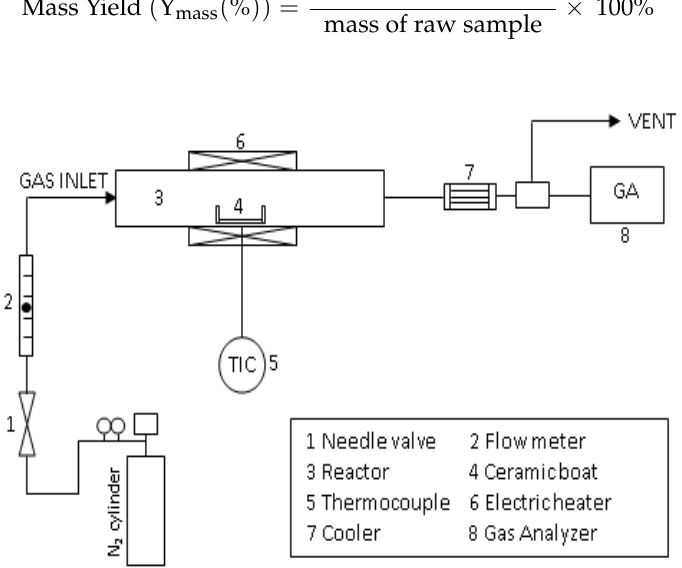
Figure 1. Schematic diagram of the horizontal tubular reactor used in this study.